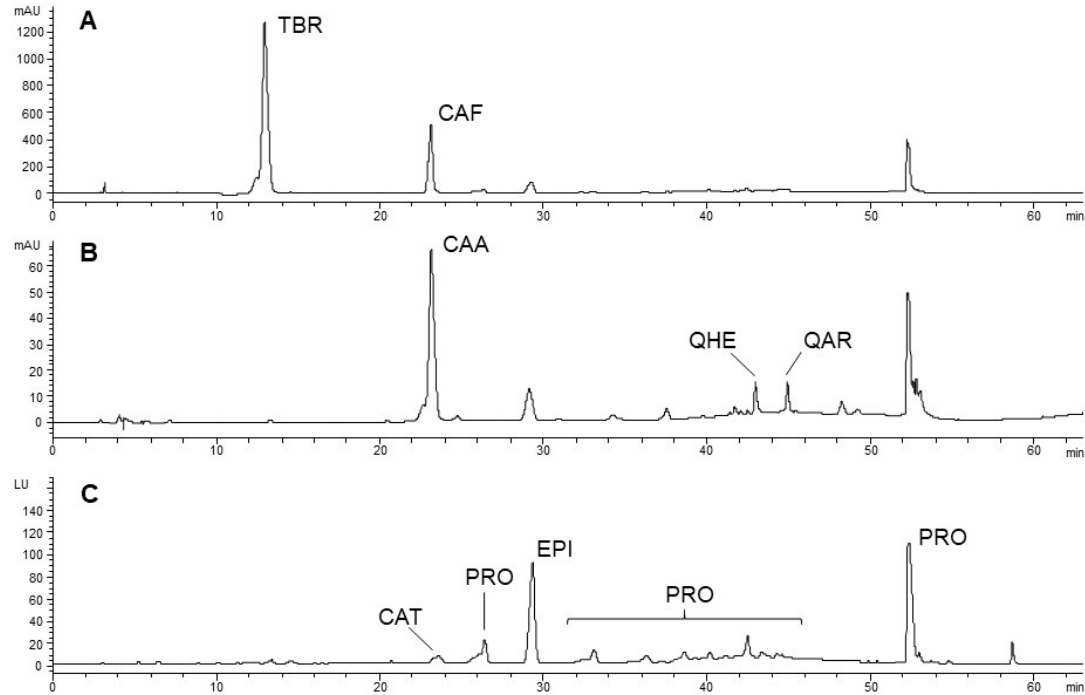
Figure 1. Chromatographic profile of raw O’Payo bean extract (2016): diode array detection (DAD) 280 nm ( A ) and 330 nm ( B ); fluorescence detector (FLD) ex. 280 nm; em. 315 nm ( C ). TBR—Theobromine; CAF—Caffeine; PRO—Procyanidins; CAA—Caffeoyl aspartic acid; QHE—Quercetin hexoside; QAR—Quercetin arabinoside; CAT—Catechin; EPI—Epicatechin.